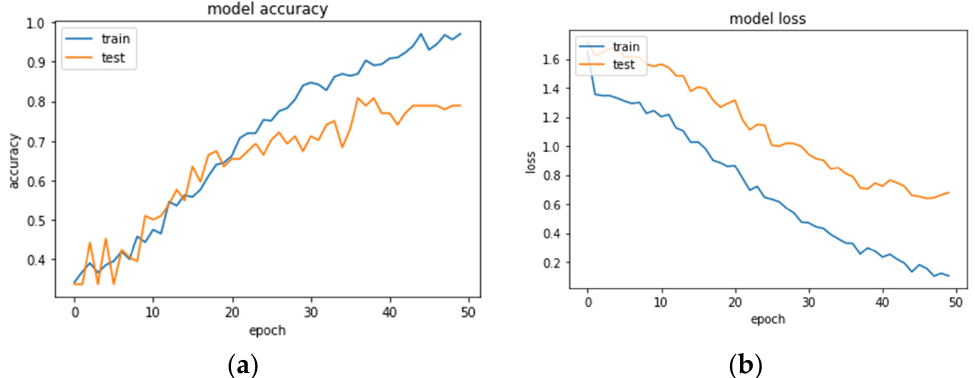
Figure 7. Training and testing of AlexNet model: ( a ) accuracy, ( b ) loss.